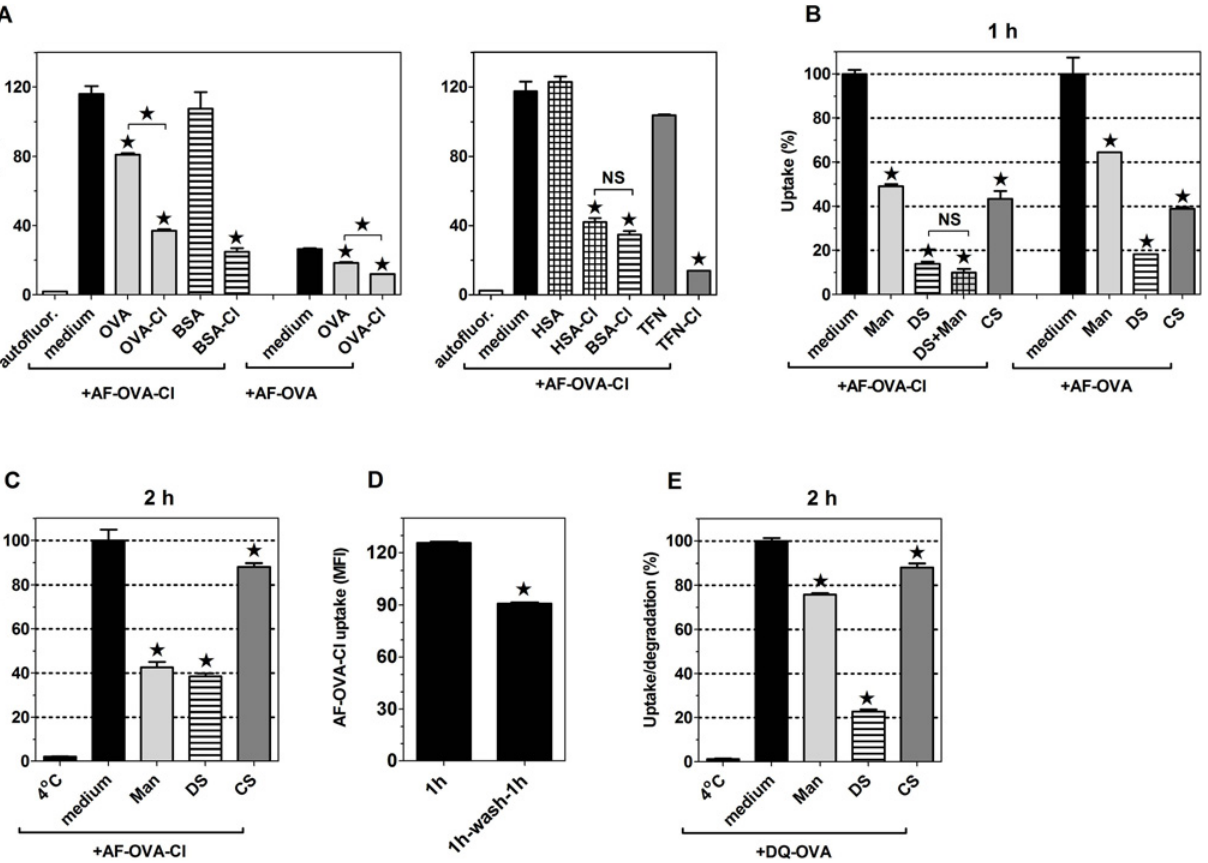
Fig 5. OVA and OVA-Cl bind to the same receptors, which are inhibited by mannan (Man), DS and CS and also shared with other HOCl-modified proteins and glycoproteins. ( A , B , C ) BM-DC were pre-incubated for 20 min with 1 mg/ml of indicated unlabelled proteins (A), 6 mg/ml Man, 0.2 mg/ml DS or CS (B, C) before the same volume of double-concentrated solution of AF-OVA or AF-OVA-Cl was added to give the final concentration of 5 μ g/ml and the incubation was continued for 1 h (A, B) or 2 h (C) in a cell culture incubator. Following washing, cell-associated fluorescence was quantified by flow cytometry. ( D ) BM-DC were incubated for 1 h with 5 μ g/ml AF-OVA-Cl, washed and either directly assessed for antigen uptake or incubated for another 1 h in medium alone before the cell-associated fluorescence was measured. ( E ) Following pre-incubation with DS or Man, BM-DC were incubated for 1 h on ice with 20 μ g/ml DQ-OVA. Unbound DQ-OVA was washed out and the cells were either directly assessed for DQ-OVA binding ( “ 4°C ” ) or transfer to 37°C for 2 h before the measurement. Results shown are averages ± SEM of triplicates obtained in single experiments, each repeated at least 3 times with similar results. Statistical analysis was performed with ANOVA, followed by the Tukey-Kramer post-test (A-C, E) or with the Student ’ s t-test (D). * , p < 0.05; NS, non-